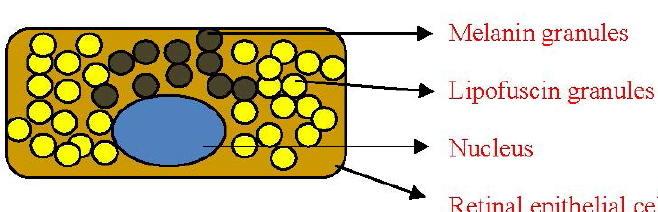
Figure 1 : Diagram of ageing retinal pigment epithelial cell showing distribution of lipofuscin and melanin